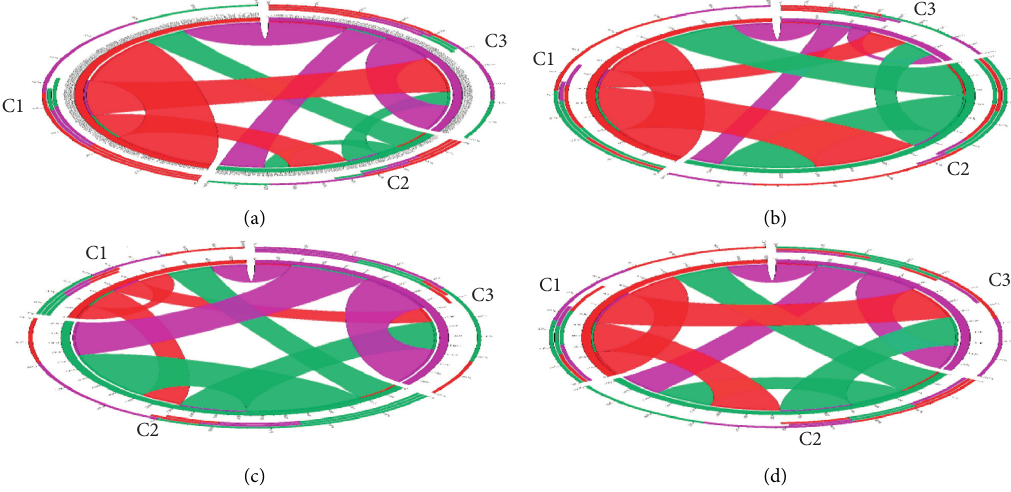
Figure 1: Intercommunity and intracommunity virtual water flows in (a) 2002; (b) 2007; (c) 2012; (d)